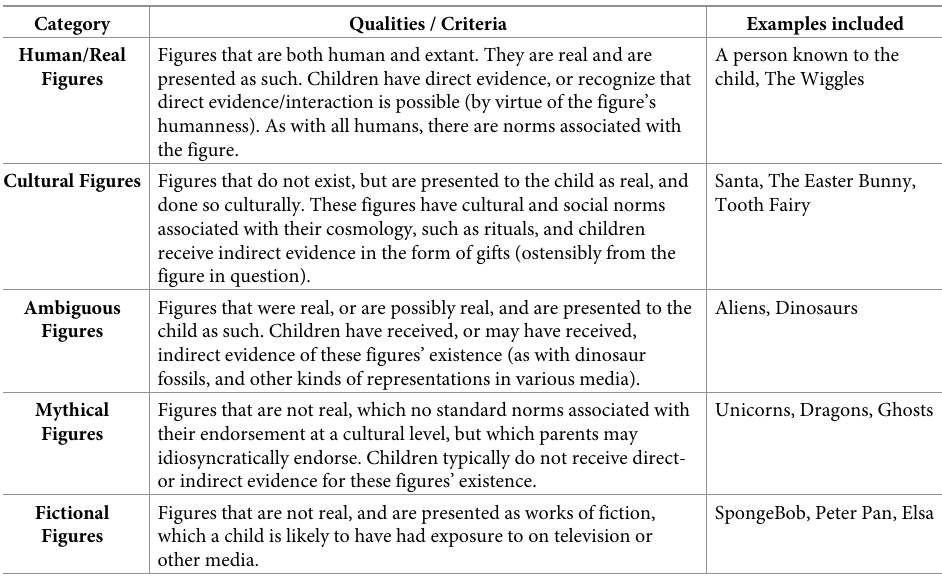
Table 2. The categories of